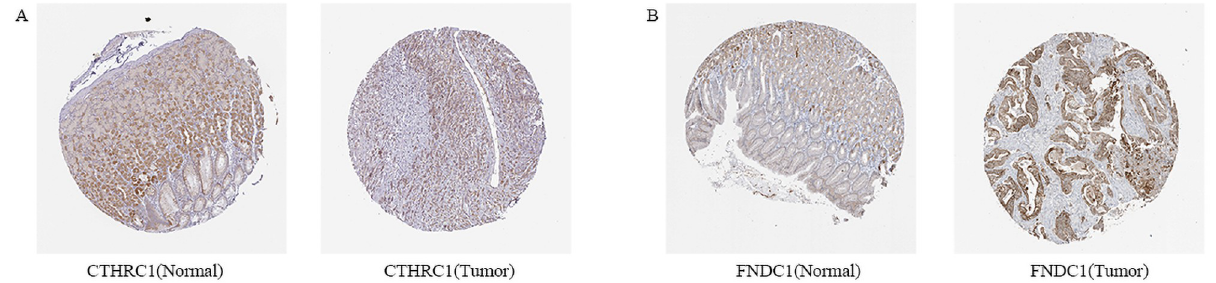
Fig 7. Immunohistochemistry (IHC) analysis of 3 hub genes on the HPA database. (A) CTHRC1 , (B) FNDC1 . ( INHBA was not found in the HPA database).